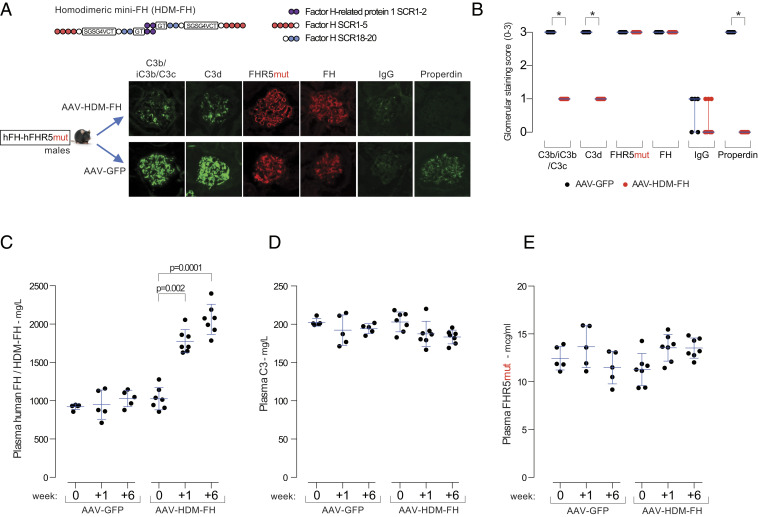
HDM-FH ameliorates glomerular C3 in hFH-FHR5mut mice. (A) Representative glomerular images and (B) staining scores for C3b/iC3b/C3c, C3d, FHR5mut, FH, IgG, and properdin in male hFH-FHR5mut mice treated with either AAV-GFP (n = 5, black dots) or AAV-HDM-FH (n = 7). Bars denote the median, and whiskers denote the interquartile range. *P = 0.0013, derived from Mann–Whitney U test. Plasma hFH/HDM-FH (C), C3 (D), and FHR5mut (E) levels after administration of either AAV-GFP or AAV-HDM-FH to hFH-FHR5mut male mice. Bars denote the mean, and whiskers denote the SD. P values are derived from two-way ANOVA with Bonferroni multiple comparisons test.